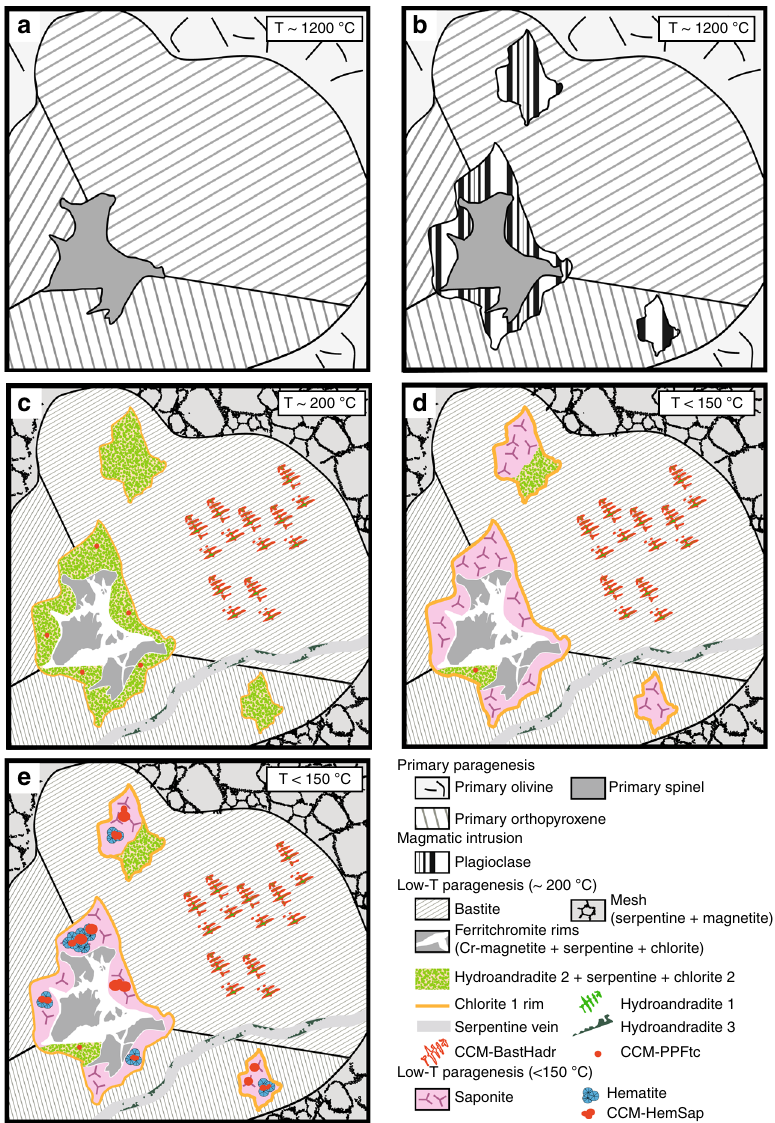
Fig. 6 Conceptual model of the different events that lead to the generation of condensed carbonaceous matter (CCM) associated with mineralogical transitions during the low-temperature aqueous alteration of the Casale serpentinite. a Primary paragenesis. Mantle harzburgite equilibrated in the spinel- stability fi eld. b Magmatic intrusion. Impregnation of the protolith at high temperature (T ~ 1200 °C) by percolating melts, resulting in the growth of secondary spinels and plagioclases. c – e Aqueous alteration at decreasing temperatures. c Serpentinization at high temperature (T > 300 °C) of the protolith, giving rise to bastite and mesh textured lizardite and magnetite, followed by low-temperature alteration (T~200 °C) of the serpentinized assemblage at low O 2 fugacity and low silica activity. These low-T aqueous alteration phases gave rise to (1) the growth of ferritchromite rims on spinels and the pseudomorphosis of plagioclase into cryptocrystalline clinochlore± lizardite ± hydroandradite (Chl2 ± Srp ± Hadr-2) assemblage, (2) the growth of hydroandradite (Hadr-1) in the bastitized orthopyroxene, and (3) the growth of hydroandradite (Hadr-3) in late serpentine veins. These different parageneses served as catalyst for the formation of different types of CCM, speci fi cally associated with Hadr-1 (CCM-BastHadr assemblage, bearing mainly aliphatic chains) and with plagioclase pseudomorphs and ferritchromite rims (CCM-PPFtc assemblage). d Alteration of the low-T assemblages by colder ( < 150 °C) fl uids with increased silica activity and slowly-increasing O 2 fugacity. It resulted in the replacement of the Chl2 ± Srp ± Hadr-2 assemblage by saponite. e Crystallization of hematite at the expense of saponite at slightly-increased O 2 fugacity and low water/rock ratio. The catalytic properties of saponite and hematite gave rise to large aggregates of CCM (CCM-HemSap assemblage) formed in paragenetic equilibrium and bearing aromatic carbon and short aliphatic